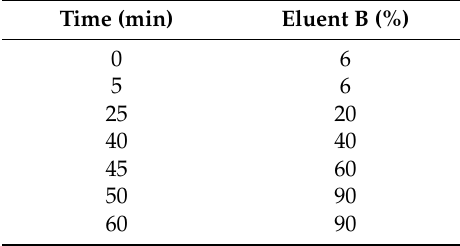
Table 1. HPLC gradient used for the anthocyanin compounds